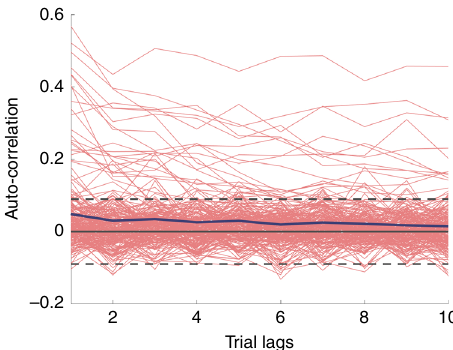
Fig. 4 The pre-stimulus modulation effect is mostly transient. The temporal auto-correlation for MI across consecutive trials in each category- selective channel. The blue solid line indicates the average auto-correlation across all electrodes. 40/246 electrodes showed signi fi cant auto- correlation ( p < 0.05, uncorrected, two-sided t -test). The dashed lines correspond to p = 0.05 threshold, uncorrected. (Source data are provided as a Source Data fi